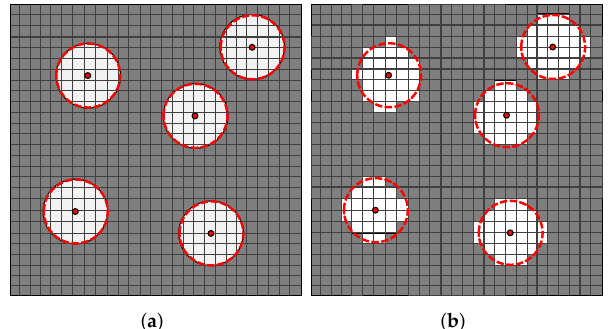
Figure 4. Representation of a fiber/matrix distribution with deviations between the expected area for the whole circumference ( a ) and the area of a set of pixels within a circumference ( b ). The white squares represent the pixels corresponding to the fibers and the gray squares represent the pixels corresponding to the matrix. The red dashed lines represent the circles obtained with the support of MATLAB function imfindcircles()